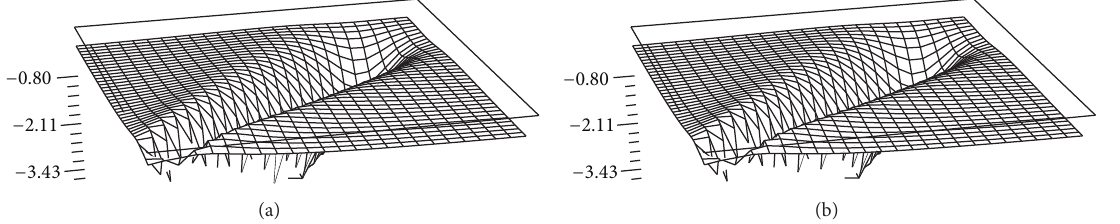
Figure 19: Zooming the component of the tensor 𝐺 𝑧𝑧 , (a) calculated in double precision, (b) calculated in single precision. In this case the rugosity is not introduced by the single precision.